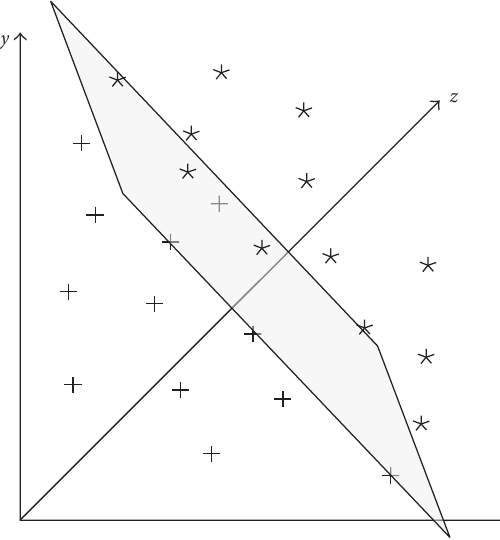
Figure 3: Separation of datasets using support vector machines. In this representation, three variables are observed for each data point, leading to a three-dimensional feature space. Transformation of the data into the feature space allows the two classes of observation to be split by the hyperplane